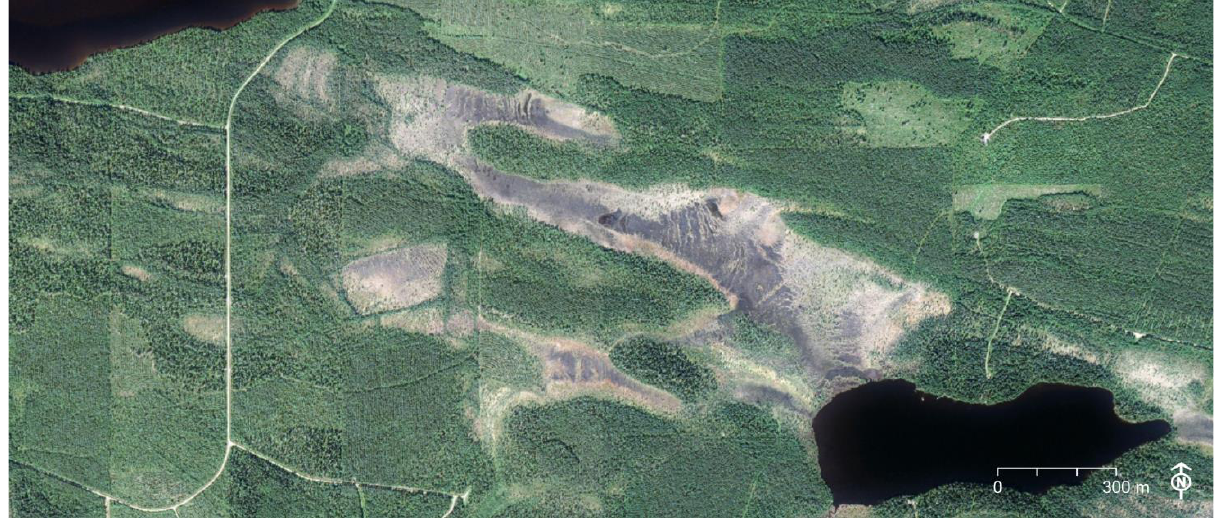
Figure 2. Patterned fens and flark fens belonging to an aapa mire landscape. Palosuo mire, Kuusamo, Finland, northern boreal zone (digital orthophoto: National Land Survey of